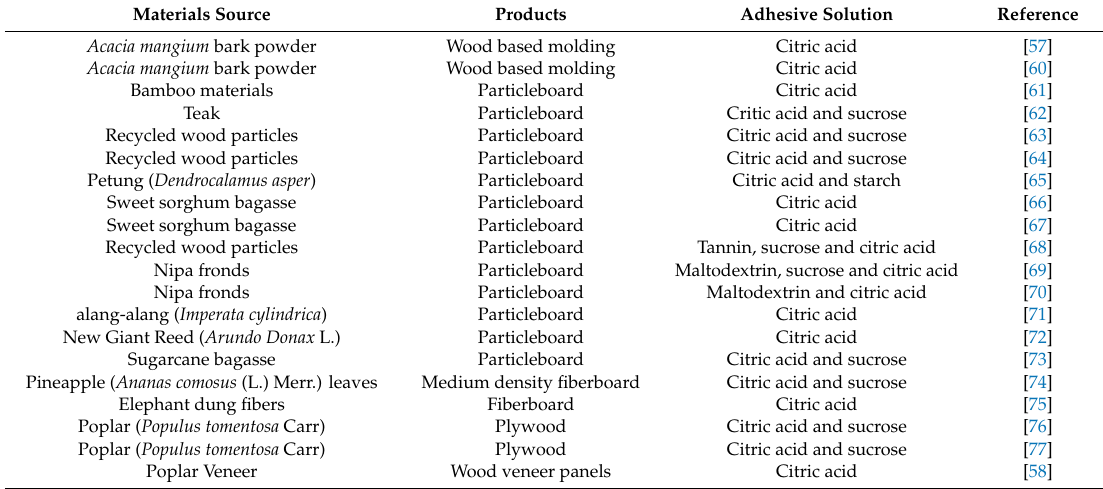
Table 2. Types materials source and products produced by using citric acid as bonding